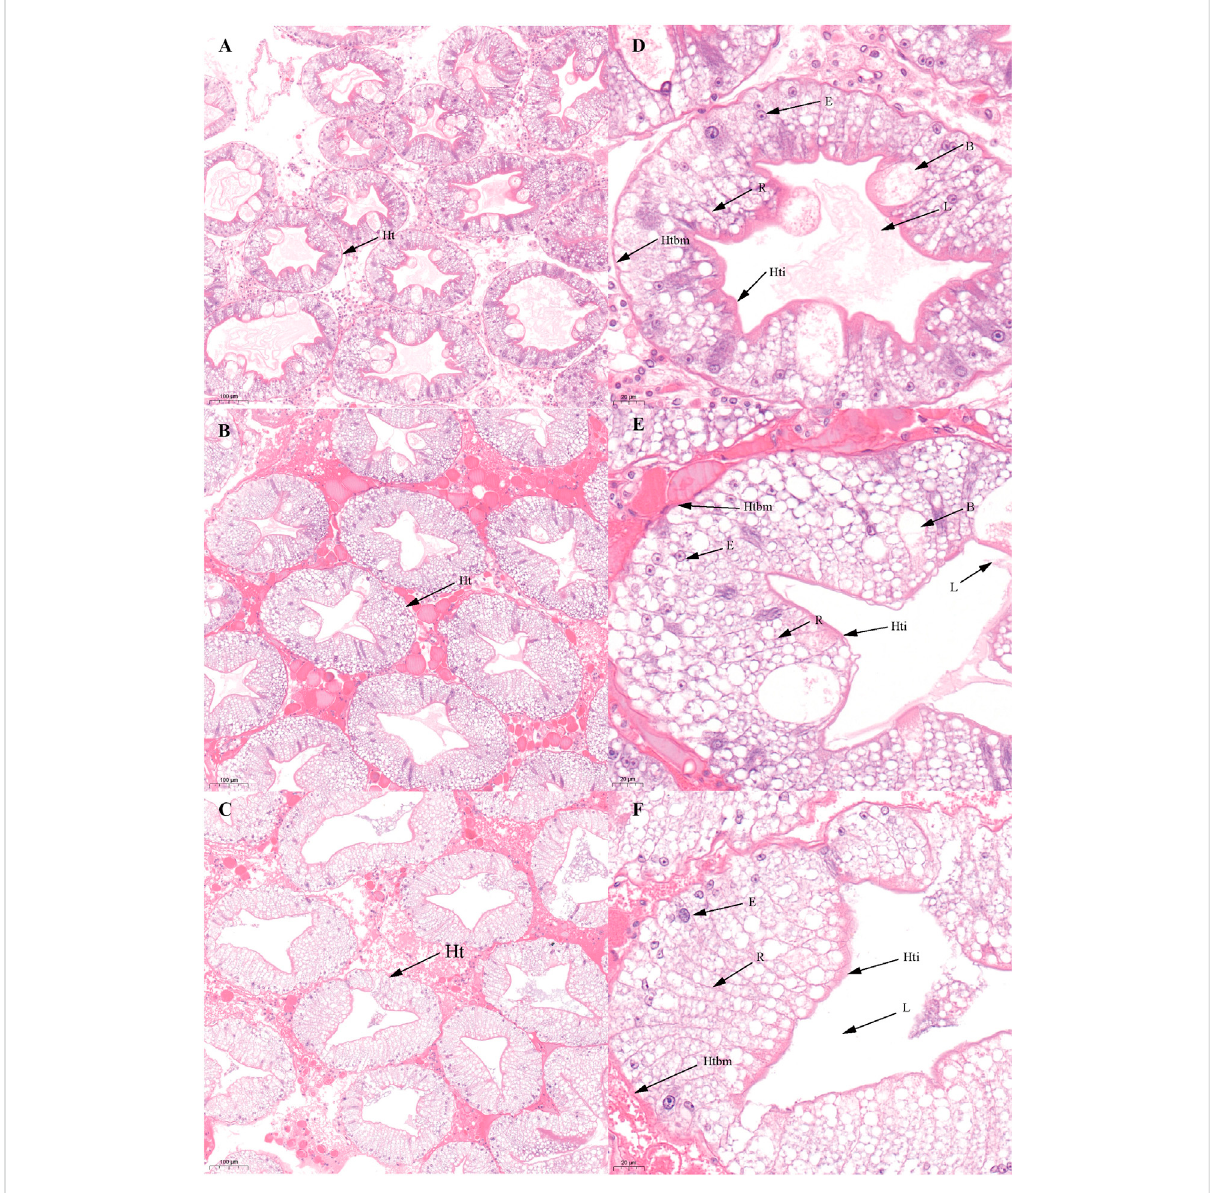
FIGURE 4 Histologicalcharacteristicsinthehepatopancreasof Scyllaparamamosain duringtheFVP. (A,D) :ovarianstage Ⅲ (F-Hep-3); (B,E) :ovarianstage Ⅳ (F-Hep-4); (C,F) : ovarian stage Ⅴ (F-Hep-5). Ht, Hepatic tubule; B, B-cell; R, R-cell; L, Lumen; Hti, Hepatic tubule intima; Htbm, Hepatic tubule basement